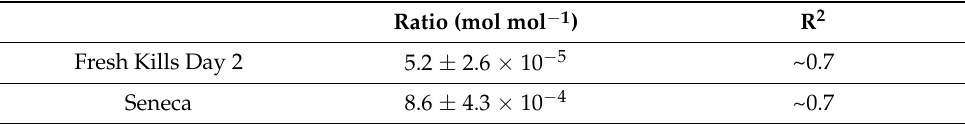
Table 3. One-minute ∆ H 2 S/ ∆ CH 4 ratios and R 2 values for each